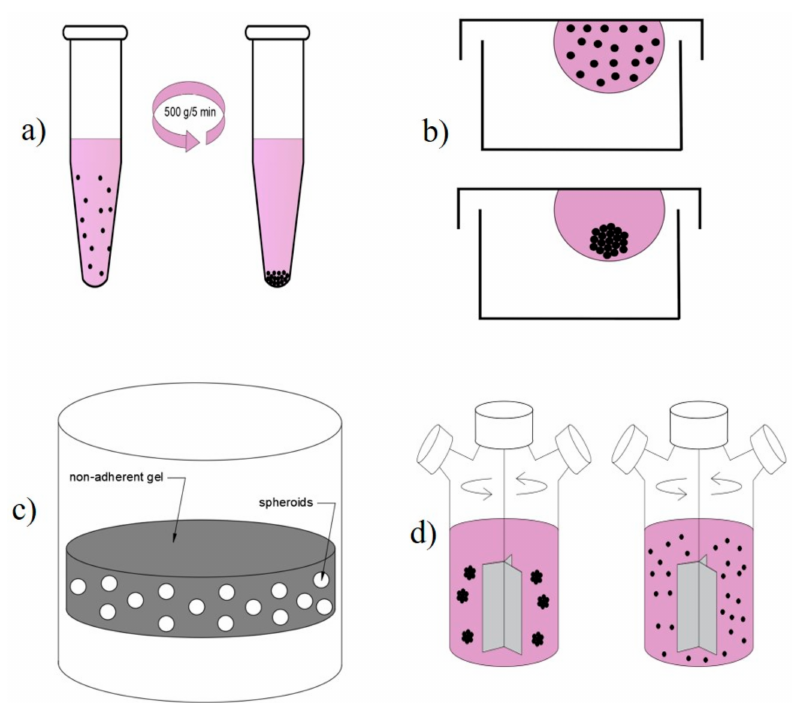
Figure 4. Technical methods of spheroid formation: ( a ) Pellet culture; ( b ) Hanging drop; ( c ) Liquid overlay; ( d ) Spinner